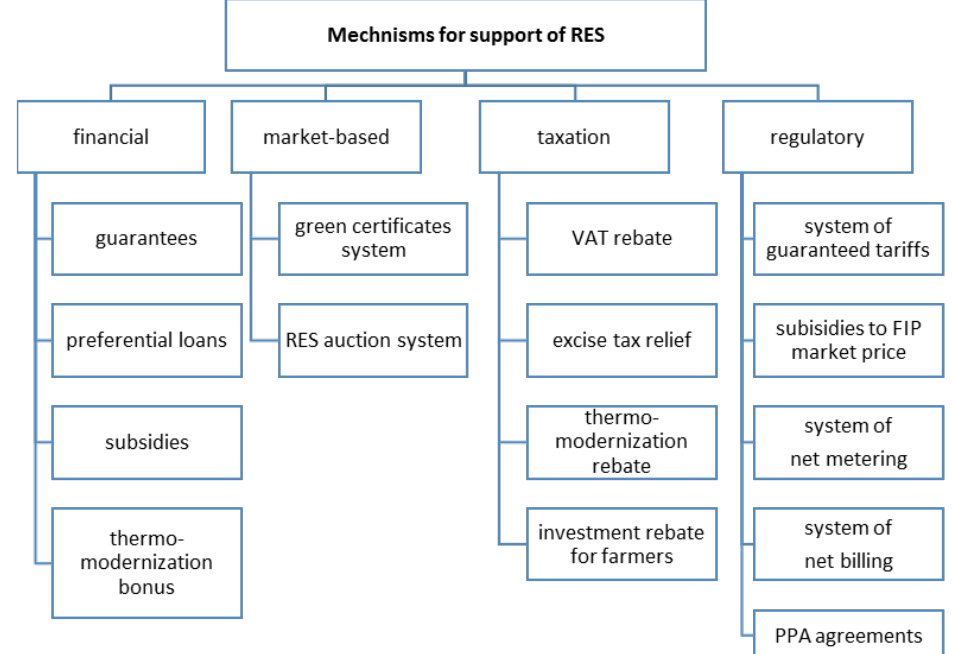
Figure 1. Mechanisms to support RES used in Poland. Source: own study.